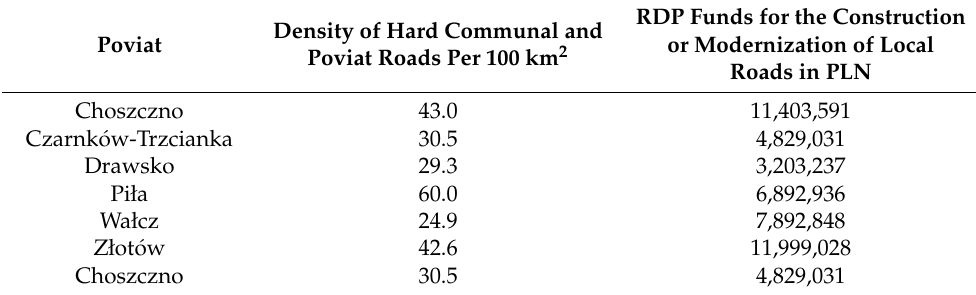
Table 2. Selected features of poviats characterizing the level of socio-economic development of the analyzed area in 2019.